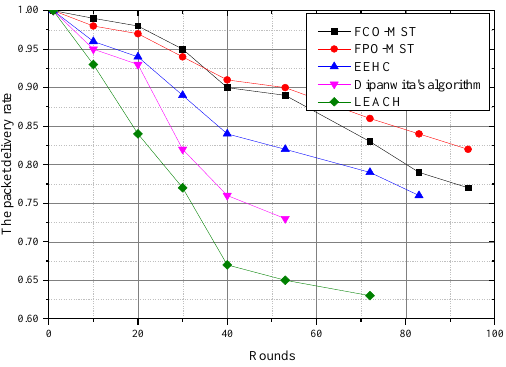
Figure 9. PDRs vs. rounds.